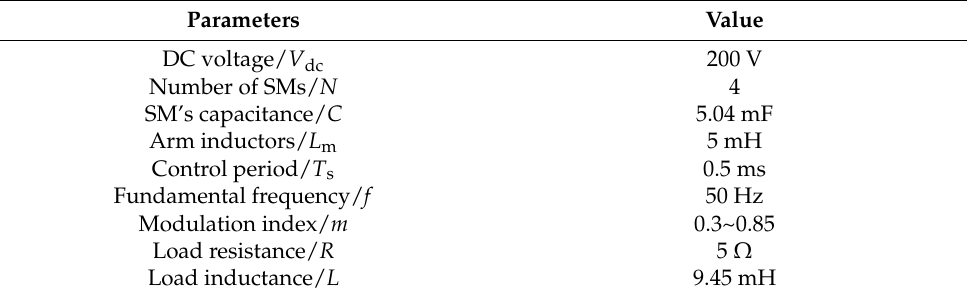
Figure 11. Experimental results of different m: ( a ) m = 0.4 ( b ) m = 0.6 ( c ) m = 0.8. 4.1. Analysis of Common Mode Voltage As shown in Figure 11, the amplitudes of CMV measured by the traditional SVPWM at m = 0.4, 0.6, and 0.8 are 16.95 V, 17.63 V, and 17.95 V, respectively, which are slightly larger than the 16.67 V calculated by Equation (9). It is mainly caused by the fluctuation of the SMs’ capacitance voltage, which is superimposed on CMV. With the 0CMV-